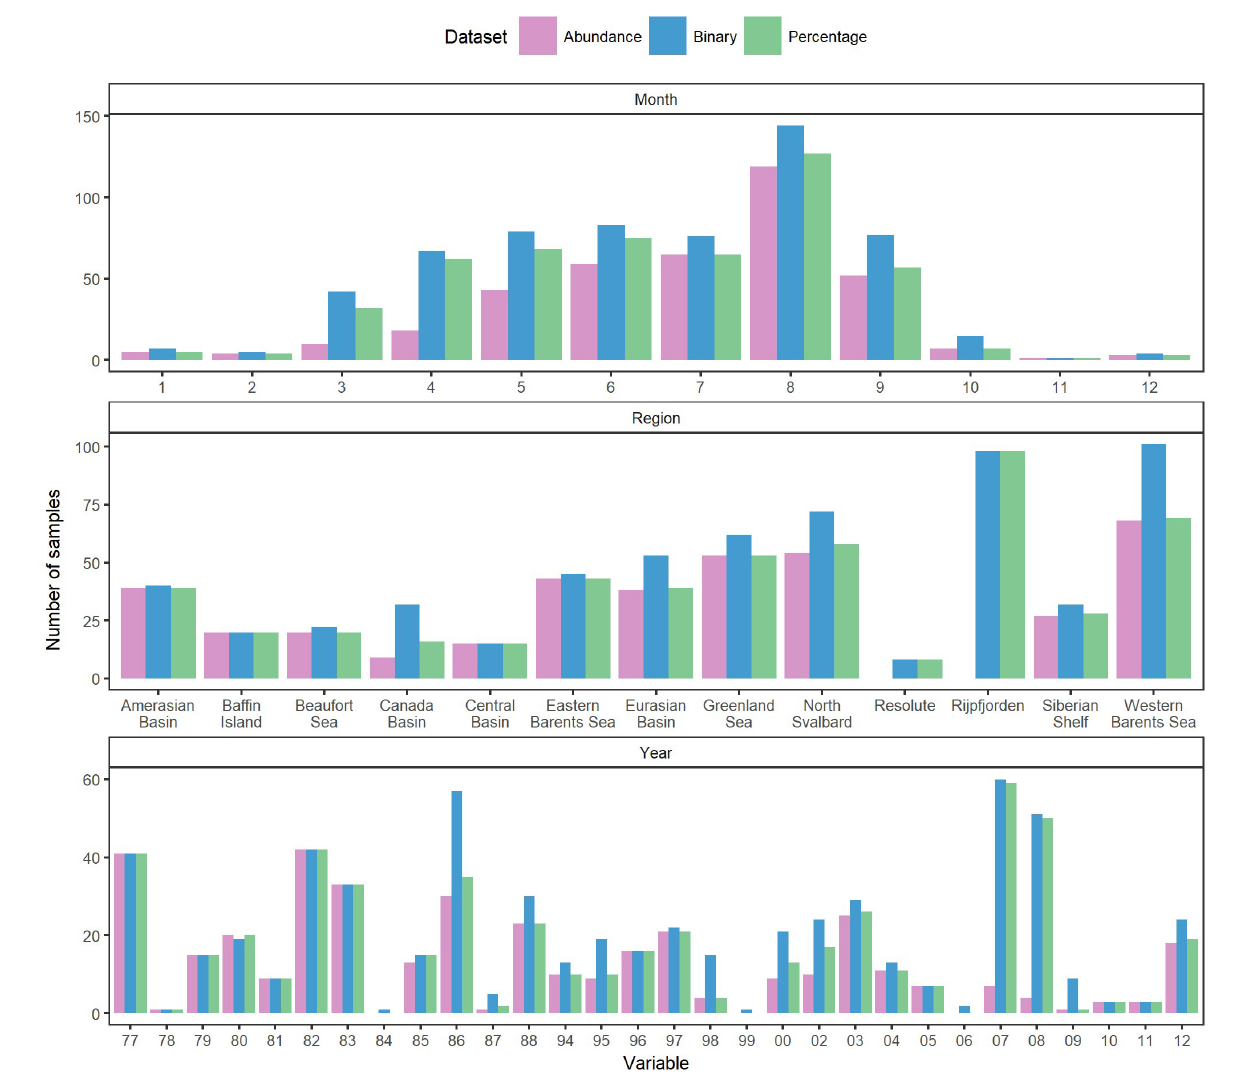
FIGURE 2 | Number of samples per year, region, and month for the three